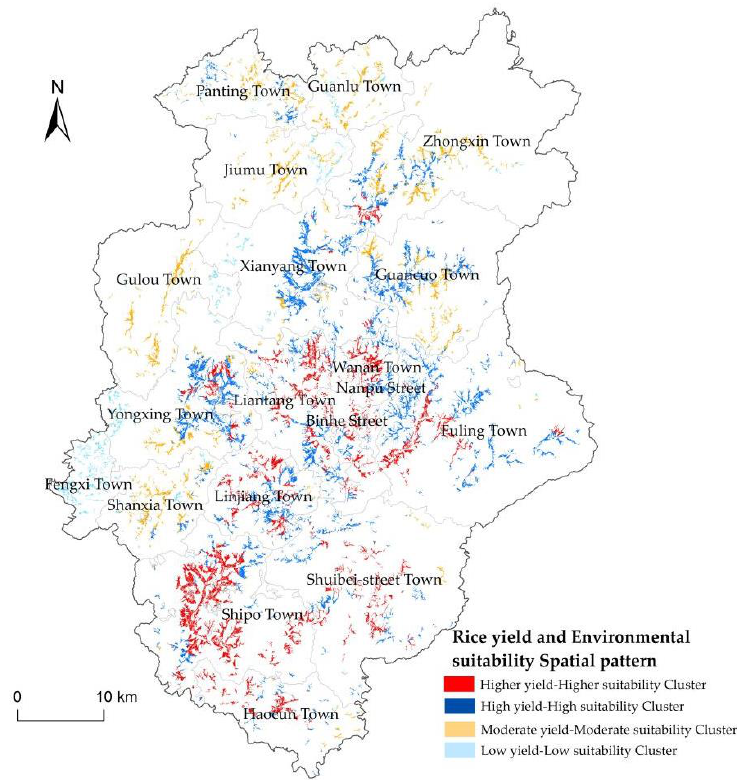
Figure 6. Spatial pattern of rice yield and environmental planting suitability in Pucheng County.